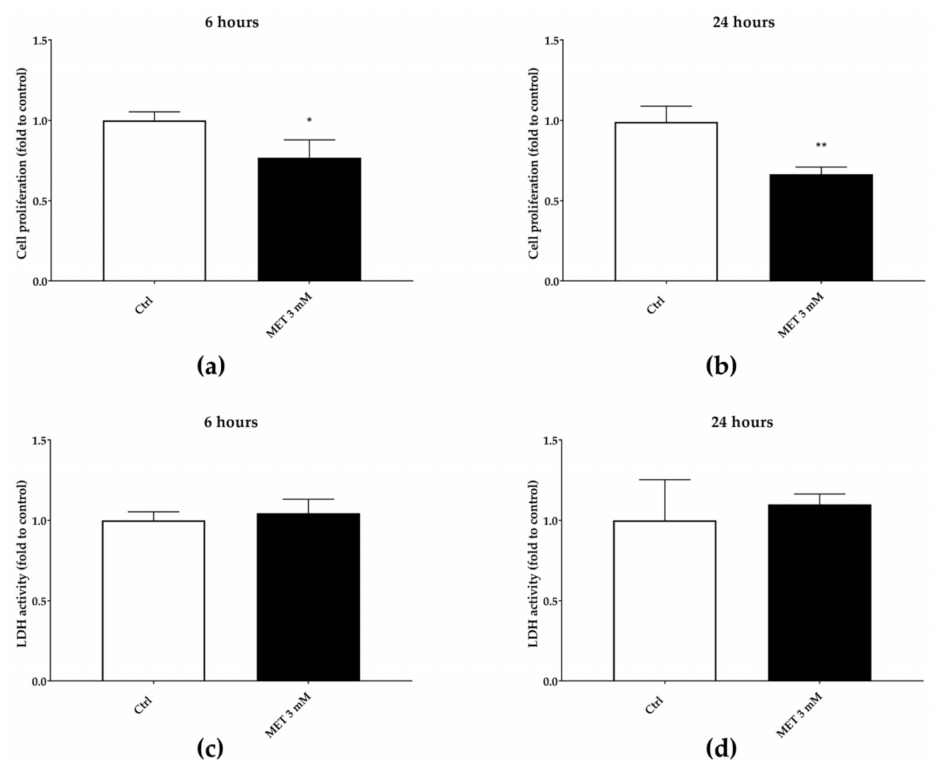
Figure 8. Three mM of 6 α -methylprednisolone (MET) reduction of cell proliferation after six hours ( a ) and 24 h ( b ). The reduction of cell proliferation is not due to cytotoxic effect, as assessed by LDH extracellular release ( c , d ).